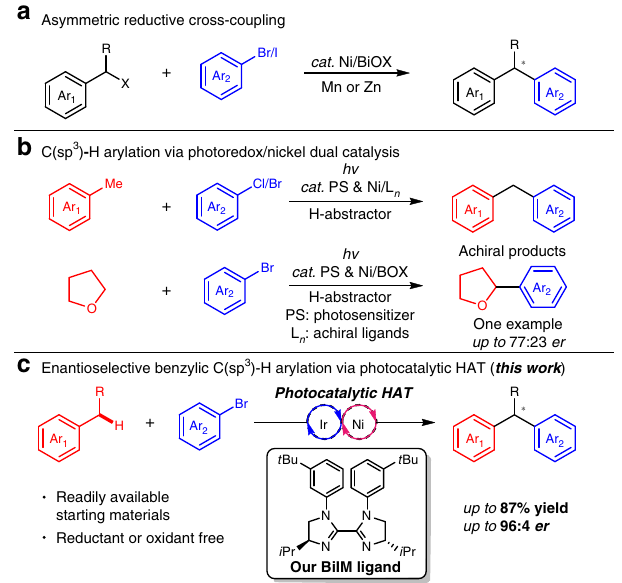
Fig. 1 Strategies for nickel-catalyzed asymmetric arylation of benzylic position or C – H bond reactions. a Asymmetric reductive cross-coupling strategies toward 1,1-diaryl alkanes with BiOX ligands. b Achiral C(sp 3 ) − H arylation via photo/nickel dual catalysis and example for the asymmetric form. c The enantioselective benzylic C( sp 3 ) − H arylation based on designed biimidazoline